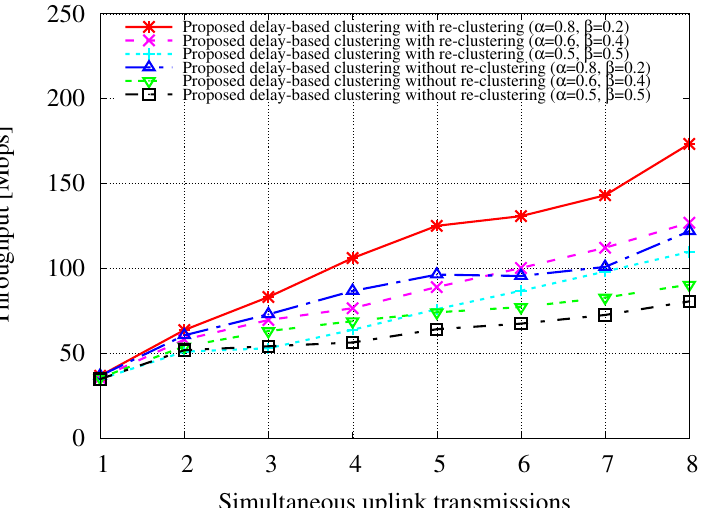
Figure 7. Network throughput performance (MCS of 80% stations changes, λ = 1.5).